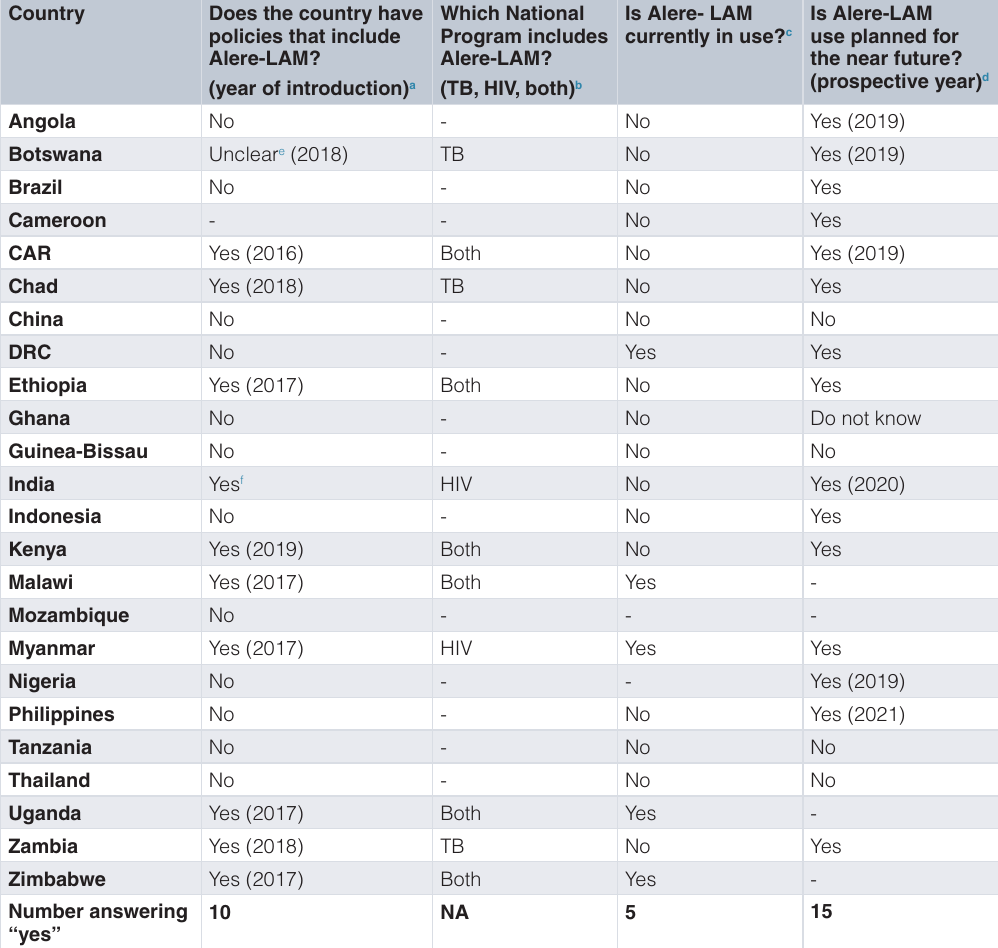
Table 1. Stages of implementation of Alere-LAM urine test by country. Country Does the country have policies that